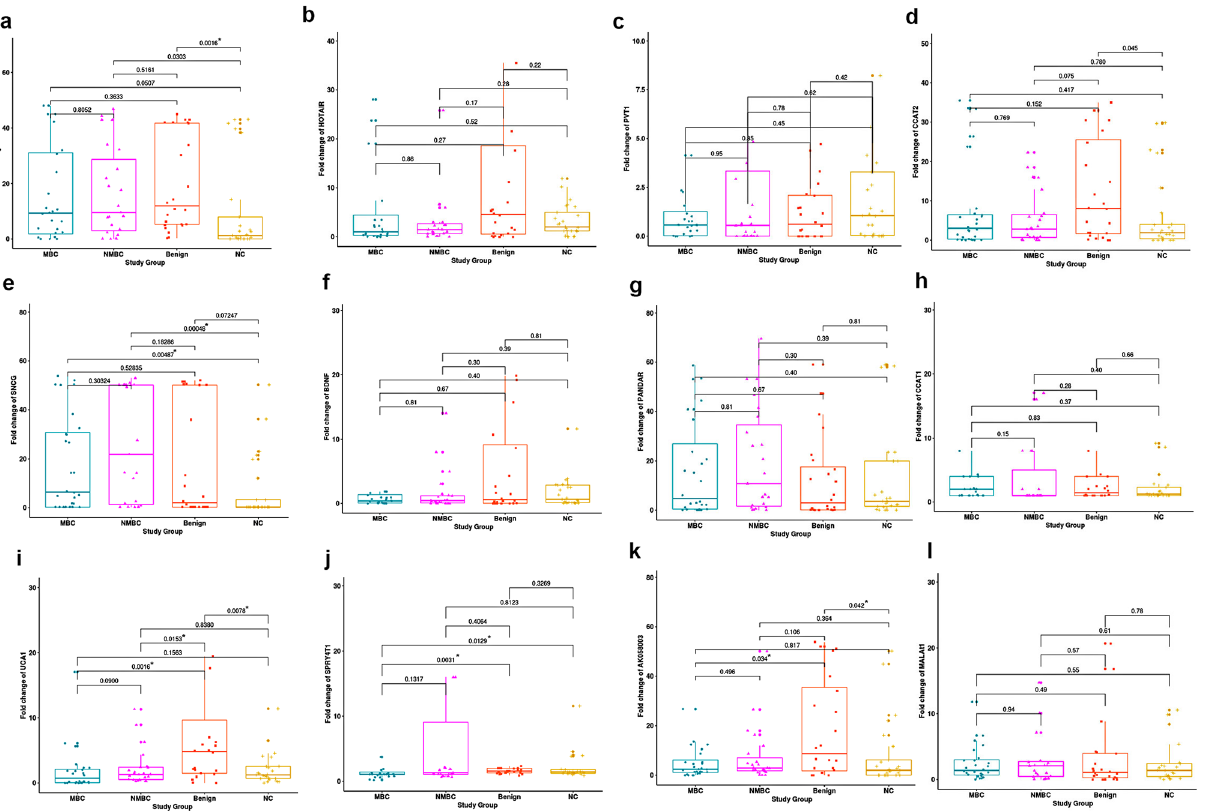
Figure 1. Differential expression of long non-coding RNAs (BCO40587, HOTAIR, PVT1, CCAT2, PANDAR, CCAT1, UCA1, SPRY4-IT1, AK058003 and MALAT1) and mRNAs (SNCG and BDNF) in different studied groups. P value refers to Mann–Whitney U